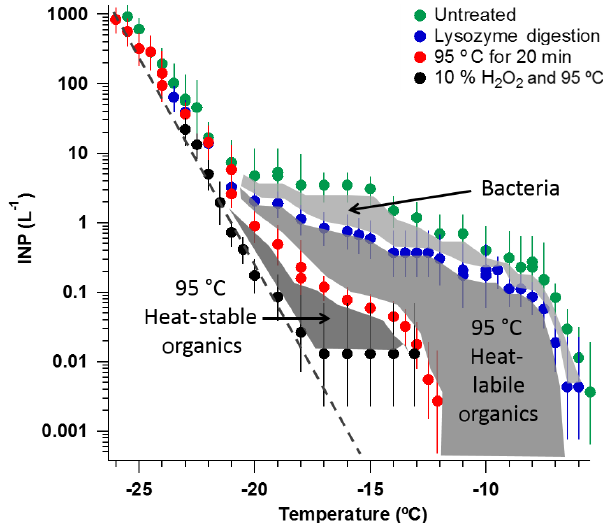
Figure 7. INP number concentrations resulting from a wheat har- vest on 30 June 2015: measured by the IS (green); wash water treated with lysozyme to selectively remove bacterial INPs (blue); after heating to 95 ◦ C for 20min (red); after peroxide digestion and heating to 95 ◦ C (black). The reduction in INP concentrations by removal of bacteria and heat-labile and heat-stable organics can be seen by the shaded areas. The dashed black line is representative of the likely underlying mineral INP